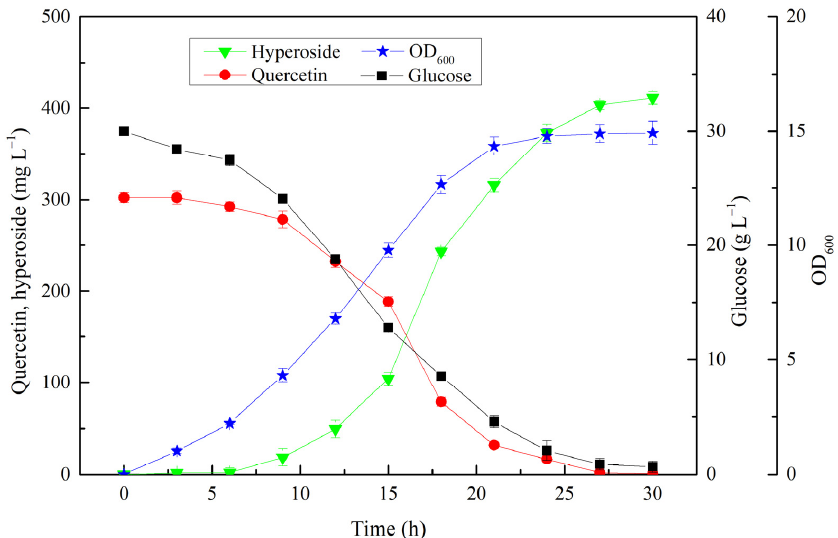
Figure 6. Time course analysis of hyperoside production under optimal fermentation conditions using recombinant strain BL21-V.